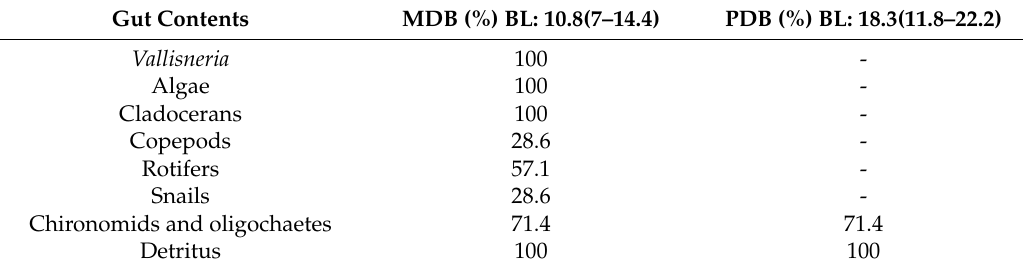
Table 3. Occurrence frequency of diet items in crucian carp guts in MDB and PDB in September and November 2010 ( n = 14). Body length (BL): mean, range